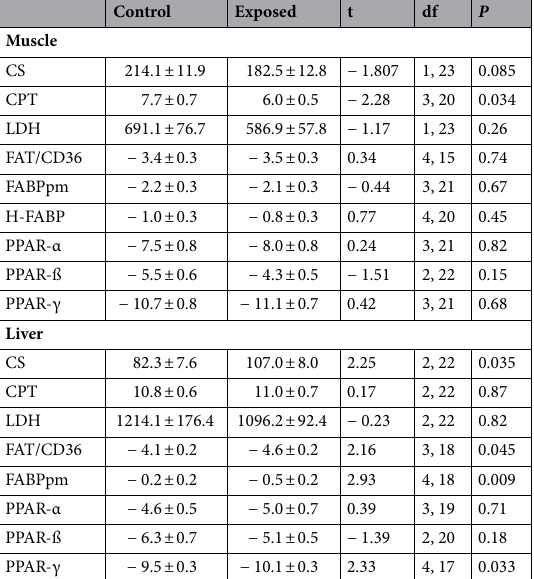
Table 1. Muscle and liver enzyme activity, fatty acid transport protein mRNA expression, and PPAR mRNA expression in yellow-rumped warblers maintained on a diet with 0.0 ppm (control) or 0.5 ppm (exposed) methylmercury for 14 d. Enzyme activity (μmol min −1 g −1 ) and expression (− ΔC T ) values are means ± SE, and test statistics are from final general linear models.